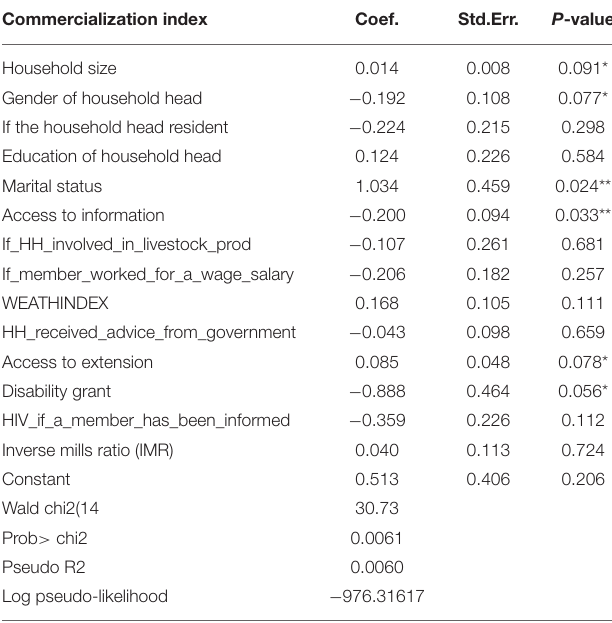
TABLE 8 | Determinants of the extent of commercialization of indigenous crops (Quasi-maximum likelihood estimates fractional logit model). Commercialization